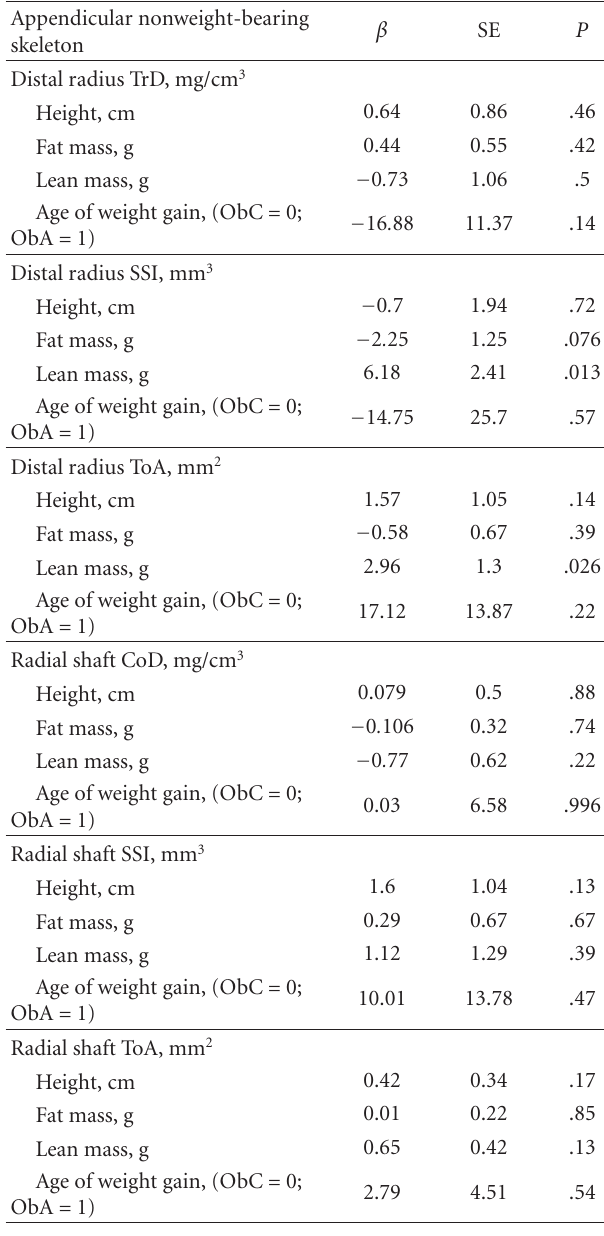
Table 4: Multiple linear regressions showing the simultaneous e ff ects of height, lean, and fat mass and age of weight gain on bone traits in the appendicular nonweight-bearing